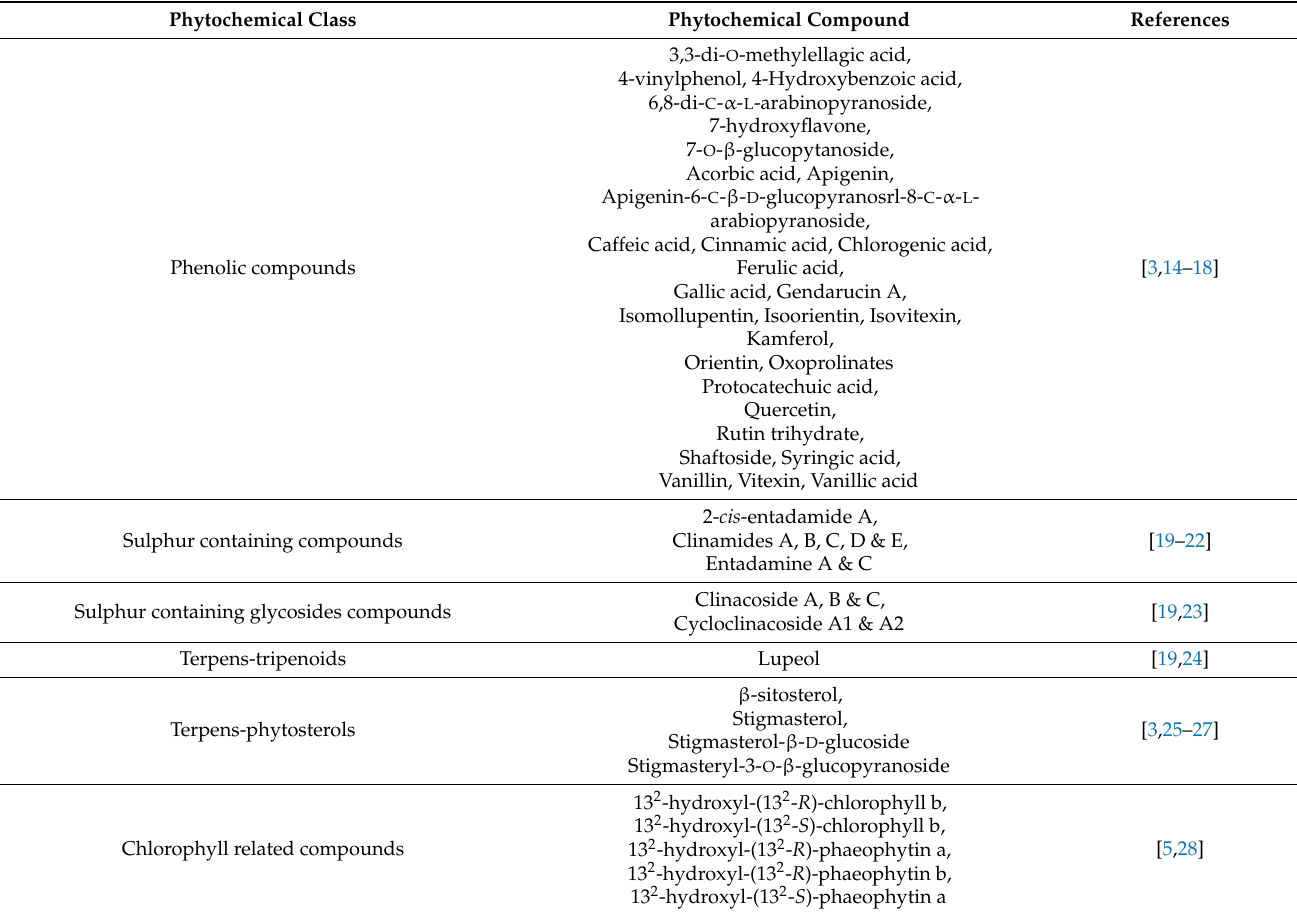
Table 3. The phytochemical classes and compounds present in C. nutans